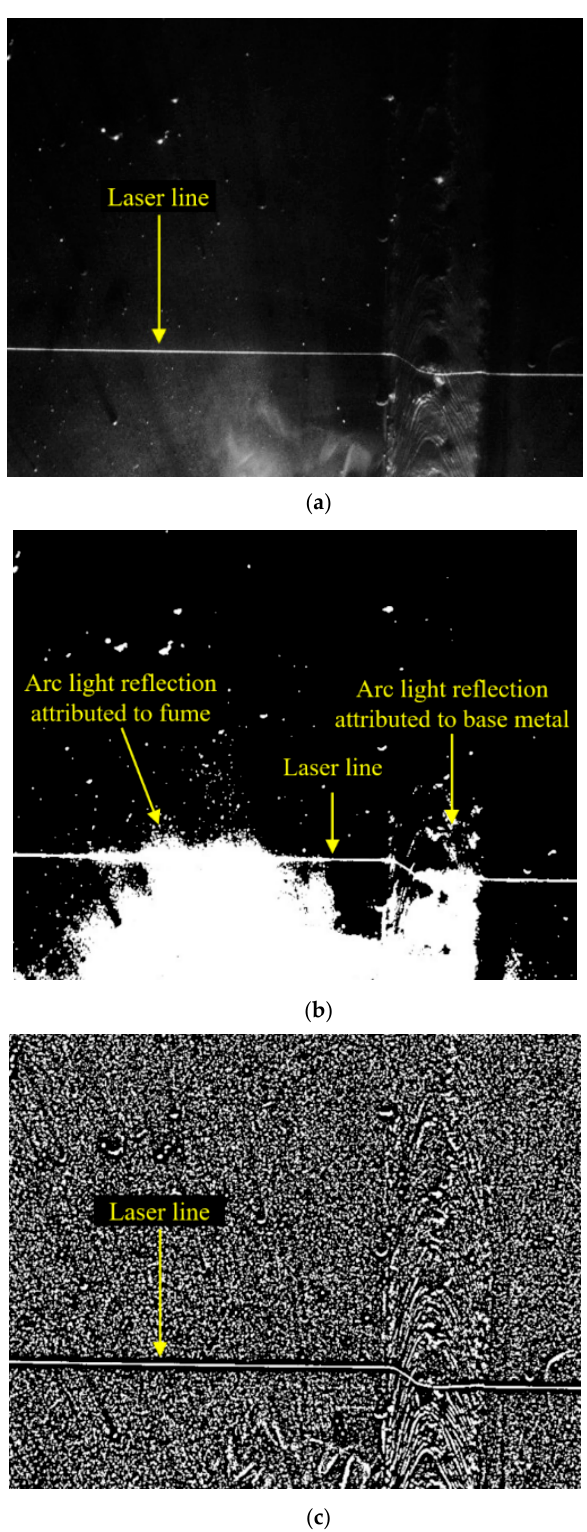
Figure 4. Thresholding operation used to identify the laser line. ( a ) Original image; ( b ) Image after global thresholding; ( c ) Image after adaptive thresholding.